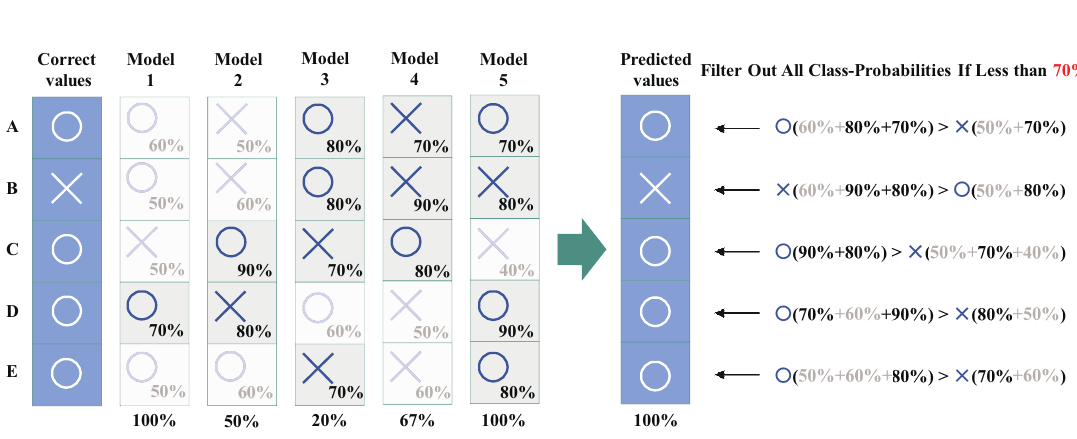
Figure 4. Example of score voting using the total of each class probability.